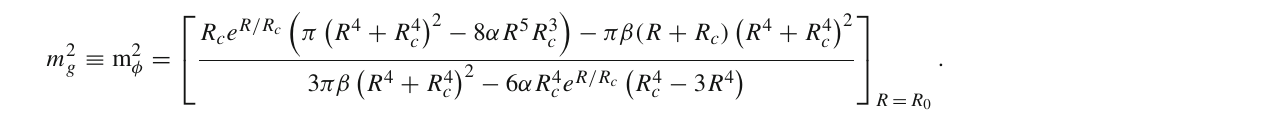
Fig. 16 Variationofcorrelationfunctions (ζ(θ)) withrespectto θ .Plot on the left shows the correlation function for tensor modes and massless breathing mode of polarization of GWs. Plot on the right shows the cor- relation function for the longitudinal mode of polarization for different